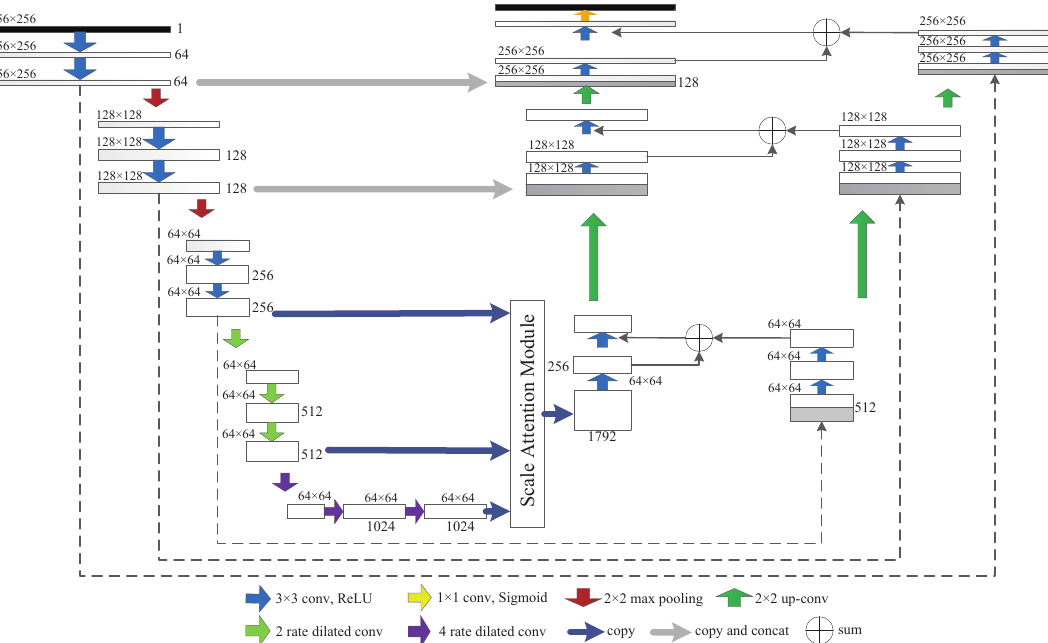
Figure 4. Complete architecture of the Scale Attention Pyramid W-Net with dilated convolution at different rates.